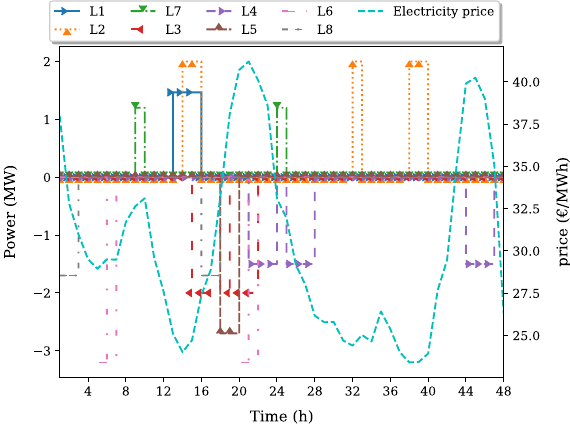
Fig. 7 Optimal scheduling for flexible loads in use case